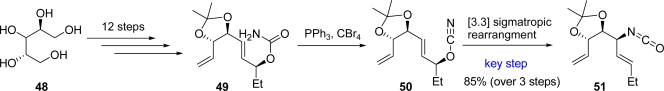
Allyl cyanate [3.3] sigmatropic rearrangment involving a [1,3] chirality transfer.